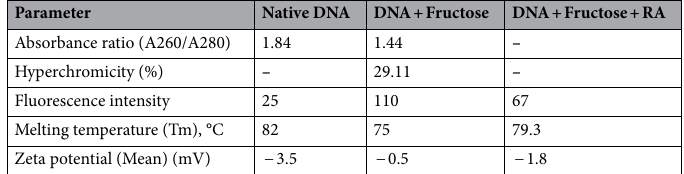
Table 1. Characterization of the native DNA glycated and treated with RA under identical